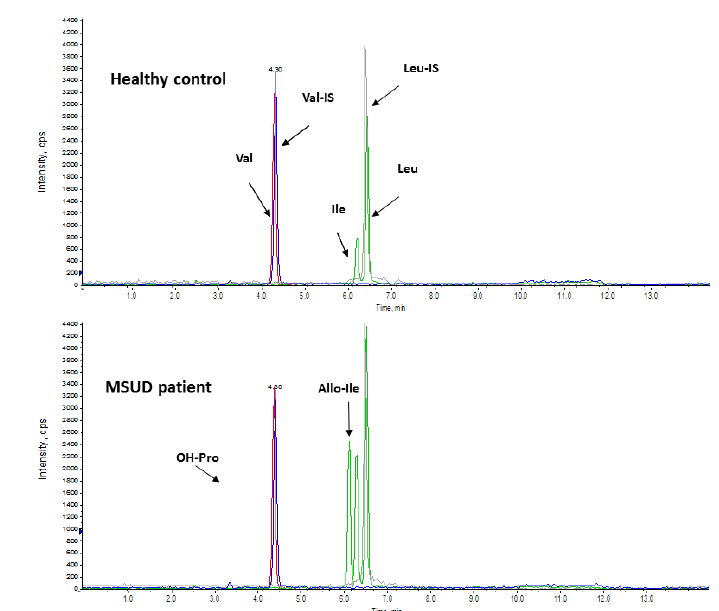
Figure 2. Chromatographic separation of branched-chain amino acids on DBS from a healthy control ( A ) and from a MSUD patient ( B ). The application of LC-MS / MS based testing allows several isobaric compounds, including Alloisoleucine (Allo-Iso), the pathognomic biomarker of MSUD to be identified.